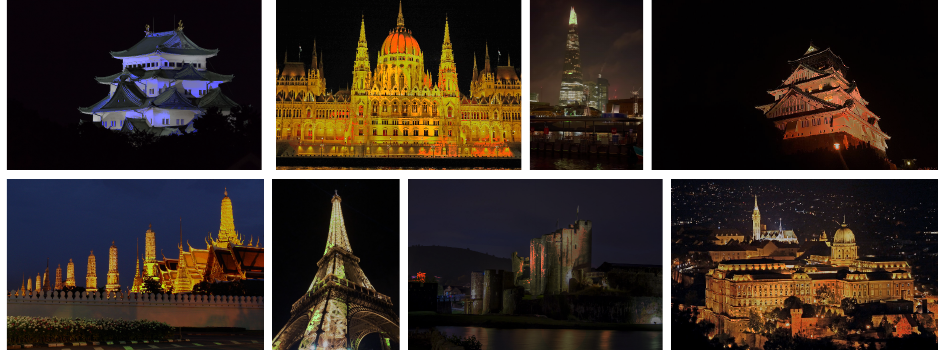
Figure 15. Rendering results with omnidirectional diffusion (JBF).